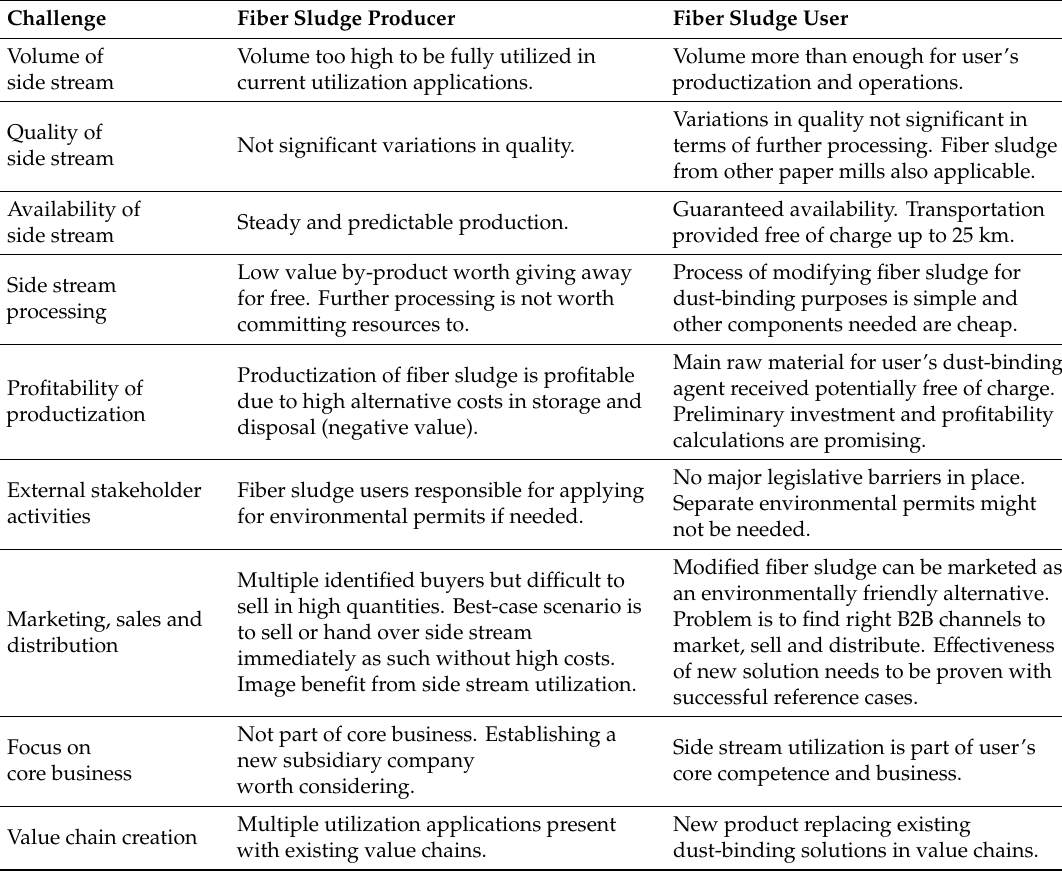
Table 1. Challenges of productizing industrial side streams and their significance in the case of fiber